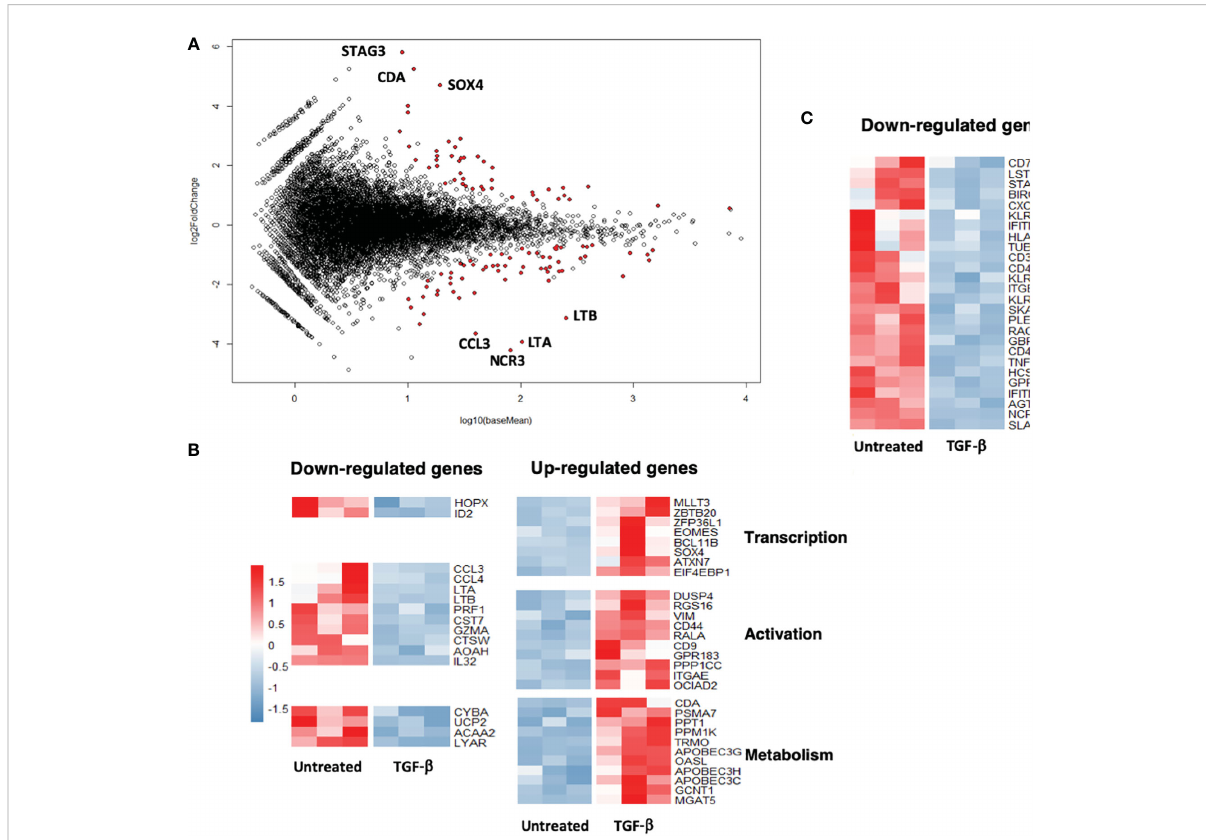
FIGURE 3 TGF- b exposure impacts the transcriptome of human V g 9V d 2 T cells. Human PBL-expanded V g 9V d 2 T cells were pretreated, or not, with TGF- b (10 ng/mL) for 72 h prior to RNA extraction. Comparative DGEseq analyses were performed on bulk RNAseq samples, data were analyzed using the R software. MA plot (A) and heat maps (B) and (C) representing genes (indicated functions) that have been retrieved as differentially expressed following TGF- b exposure or not ( Untreated ). Colored scale, fold change expression. Down-regulated genes ( blue ); Up-regulated genes ( red